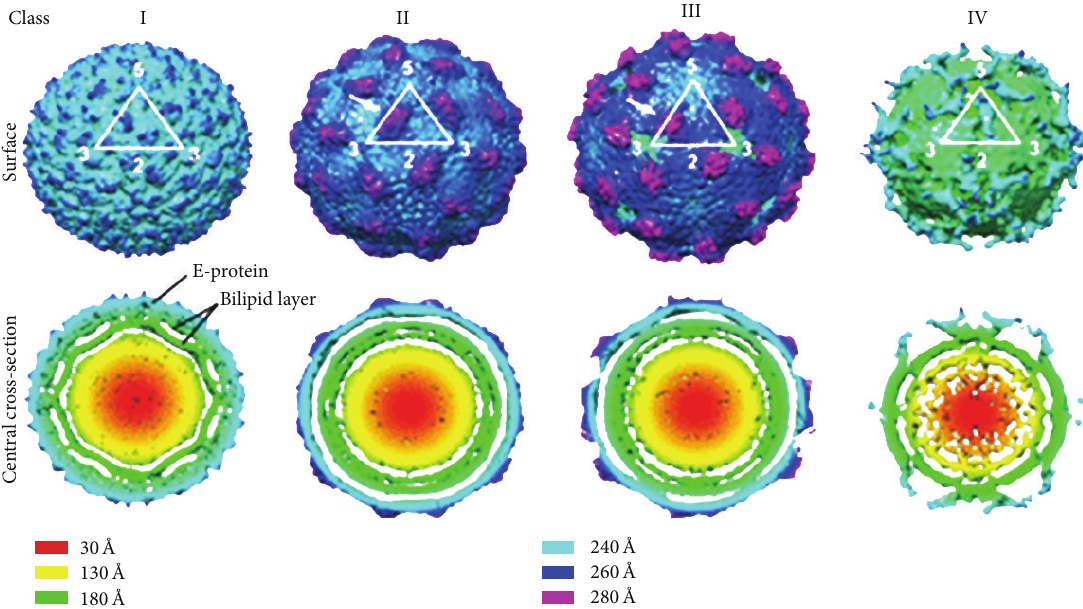
Figure 15: Cryo-EM maps reconstructed from class I to IV particles present in the DENV2 sample incubated at 37 ∘ C. The surfaces of the maps (above) and their central cross-sections (below) are colored according to their radii (shown in the lower panel). The white triangle represents an icosahedral asymmetric unit, and the corresponding 2-, 3-, and 5-fold symmetry vertices are indicated. Maps generated from the class I particles are similar to the previous published DENV-2 maps. Class II and III maps showed that the particles in these classes have bigger radii, indicating that the virus had expanded. There are protruding densities on the virus surface between the 5- and 3-fold vertices (white arrows). The class IV map showed very poor density on the E protein layer, indicating that the E protein had lost its icosahedral symmetry. With permission from Fibriansah et al.